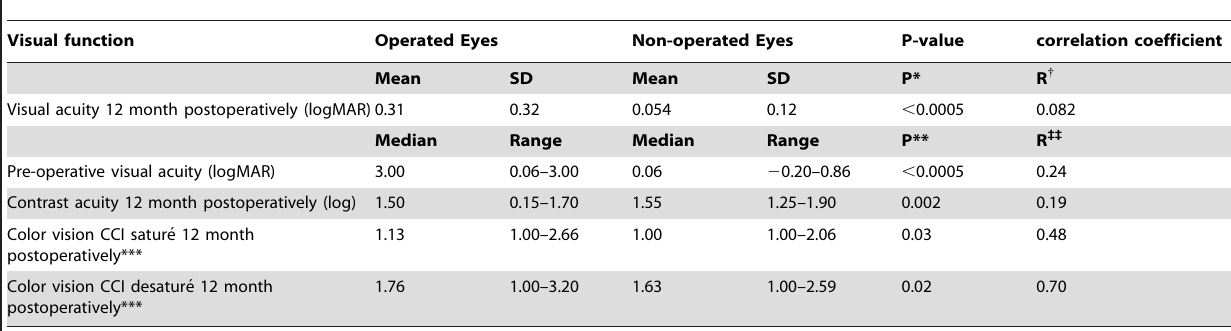
Table 2. Tests of visual functioning in operated and non-operated fellow eyes(n